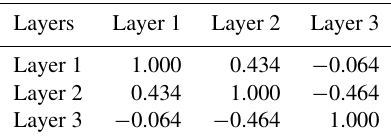
Table 4. Correlation matrix comparing the breeding facility density map and the filled contour maps for Hg and Cu data for the Yicheng area (calculated using the Band Collection Statistics spatial analyst tool of the ArcGIS software package).